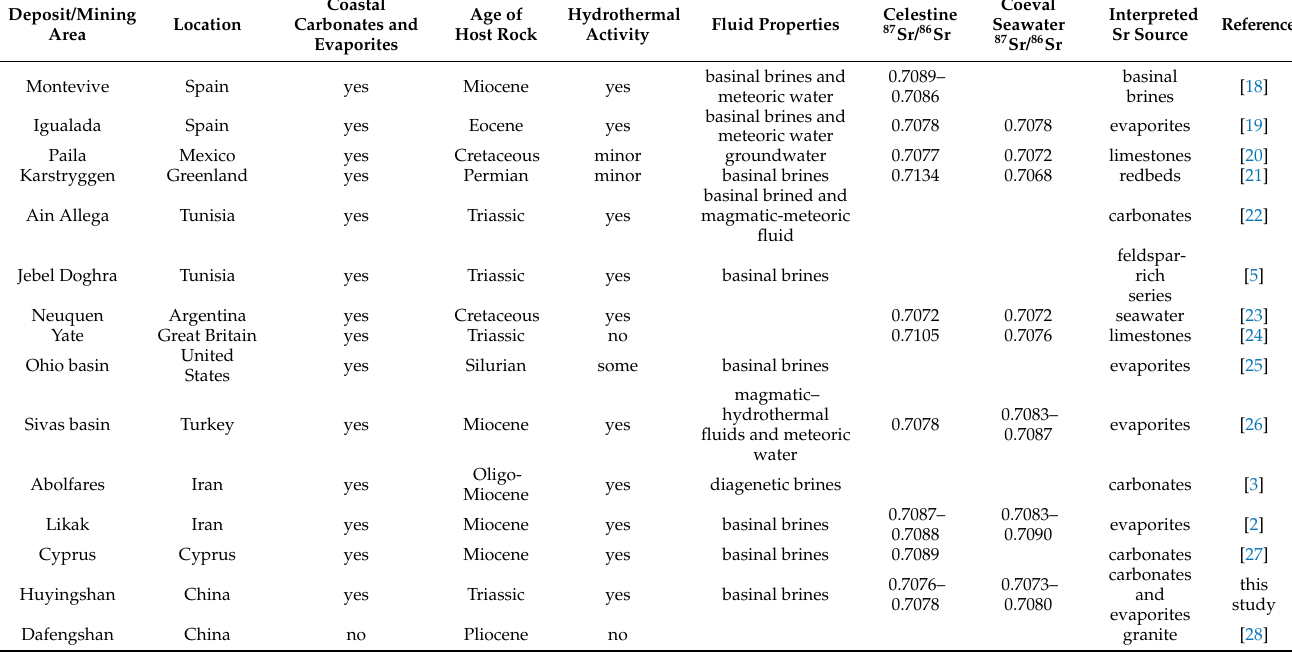
Table 1. Properties of some celestine deposits in the